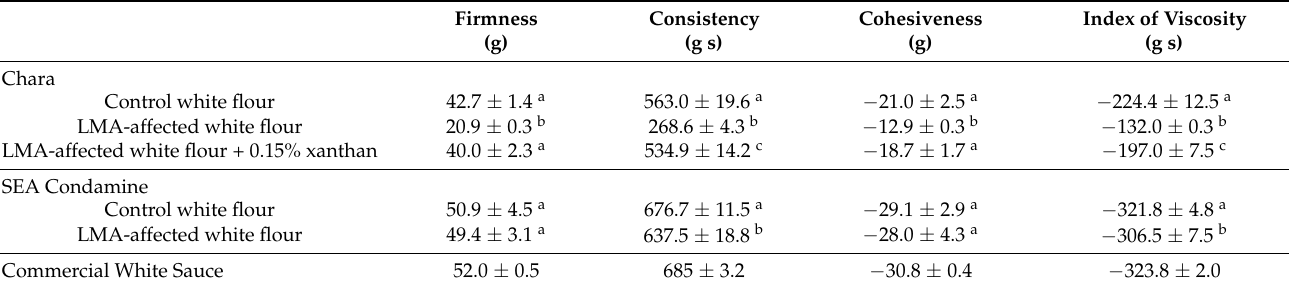
Table 3. Comparison of white sauce texture properties processed from control and LMA-affected white flour. Results are presented as mean of biological quadruplicates ± standard deviation for Chara and SEA Condamine, whereas results are presented as technical quadruplicates ± standard deviation for commercial white sauce. Values marked by different letters for the same cultivar within a column indicate significant differences ( p ≤ 0.05). Commercial white sauce texture properties results were not included in the statistical